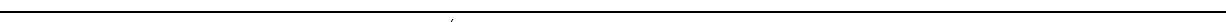
Fig. 4 Tau loss alters genetic integrity of rDNA and CDA − / − cells. a , b Representative immuno fl uorescence ( IF ) z ‐ projection images showing paired Tau foci ( green ) linked by PICH-positive UFBs in BS ( a ) and HeLa ( b ) anaphase cells. Scale bar : 5 µ m. DNA was visualized by DAPI staining ( white ). Centromeres were stained with CREST serum ( blue ) and UFBs were stained with PICH antibody ( red ). In the enlarged images, Tau foci at the extremities of UFBs are indicated by yellow arrows. c Mean number of total and Tau-positive UFBs per anaphase cell. d , f Mean number of R-UFBs per anaphase cell in untreated cell lines. e Relative number of R-UFBs per anaphase cell in BS-Ctrl (BLM) and BS-BLM cells left untreated or treated with 100 µ M tetrahydrouridine ( THU ) for 2 × 48 h or 1 mM of deoxycytidine ( dC ) for 10 h. g Mean number of R-UFBs per anaphase cell in BS-Ctrl (BLM) and BS-BLM cells left untreated or